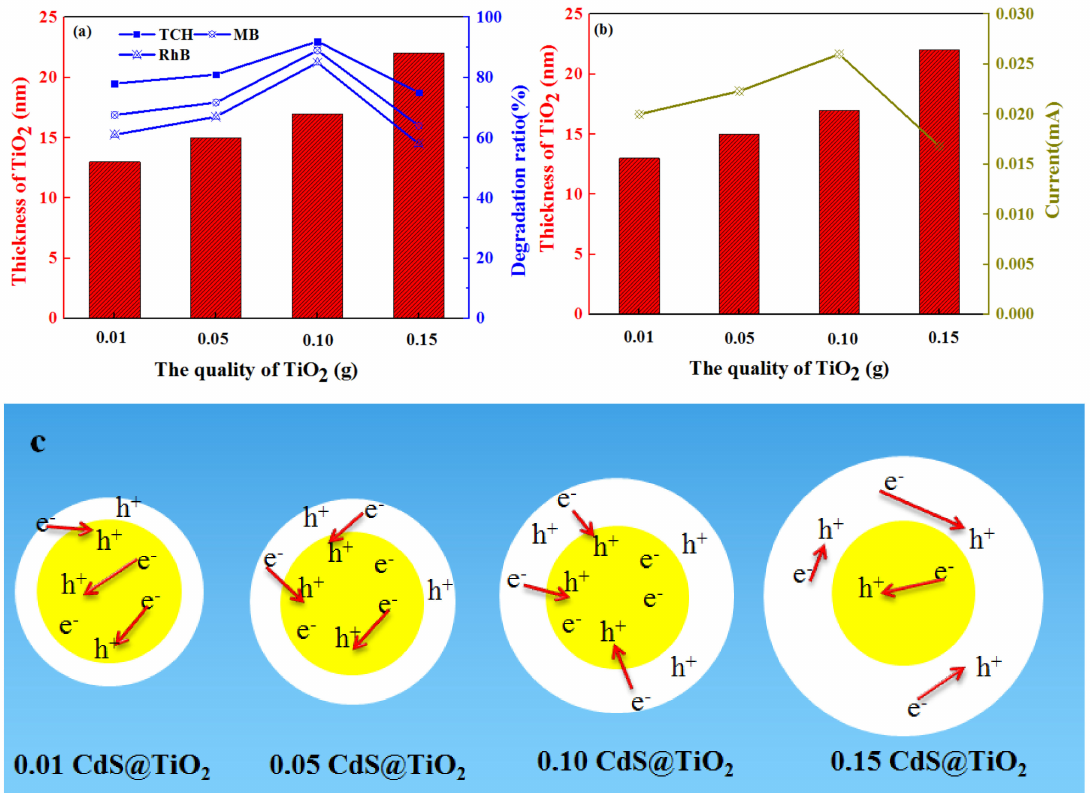
Figure 8. The relationship between layer thickness of TiO 2 shell and degradation ratio under visible light ( a ), current ( b ); the schematic diagram of electron transport on the different shell thicknesses photocatalytic ( c